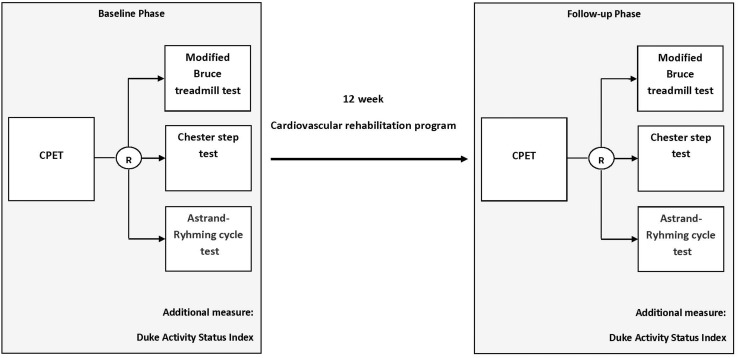
Schematic of study flow. CPET, cardiopulmonary exercise testing; R, random order.